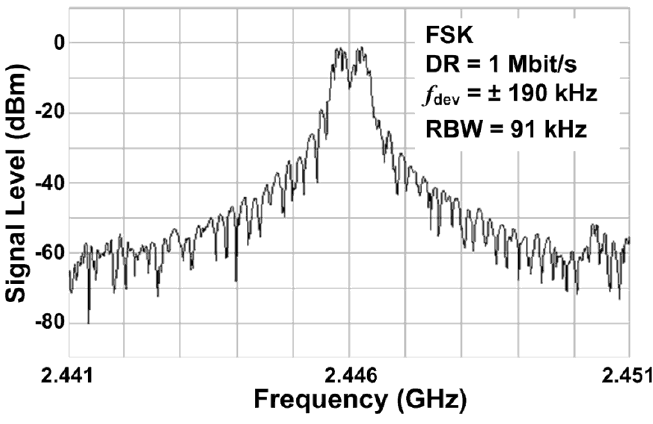
Figure 12. Measured output spectrum of the 2.4 GHz design, FSK modulated at 1 Mbit/s and ± 190 kHz frequency deviation, at a supply voltage of 1.5